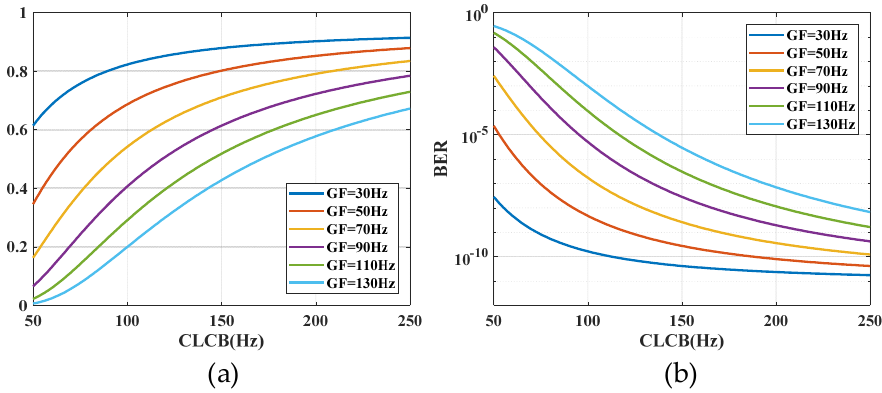
Figure 8. Relationships between ME, BER and CLCB under different GFs: ( a ) relationship between ME and CLCB under different GFs; ( b ) relationship between BER and CLCB under different GFs.